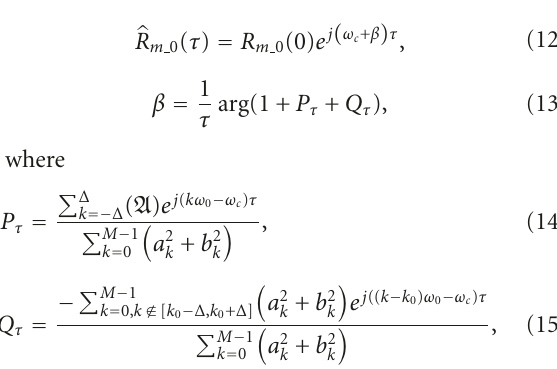
Figure 1: MSE of the MLAF-based estimator with di ff erent q , N = 256, τ = 1. Signal frequency randomly distributes between [0, π